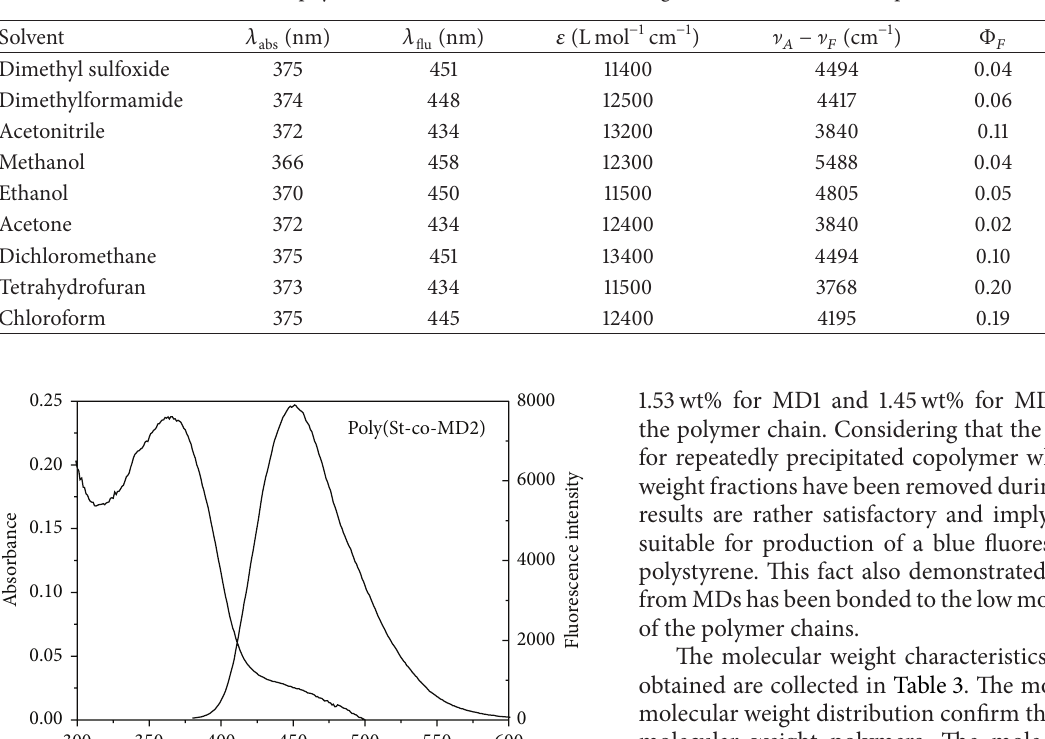
Table 2: Photophysical characteristics of the MD2 in organic solvents of different polarities (see text).